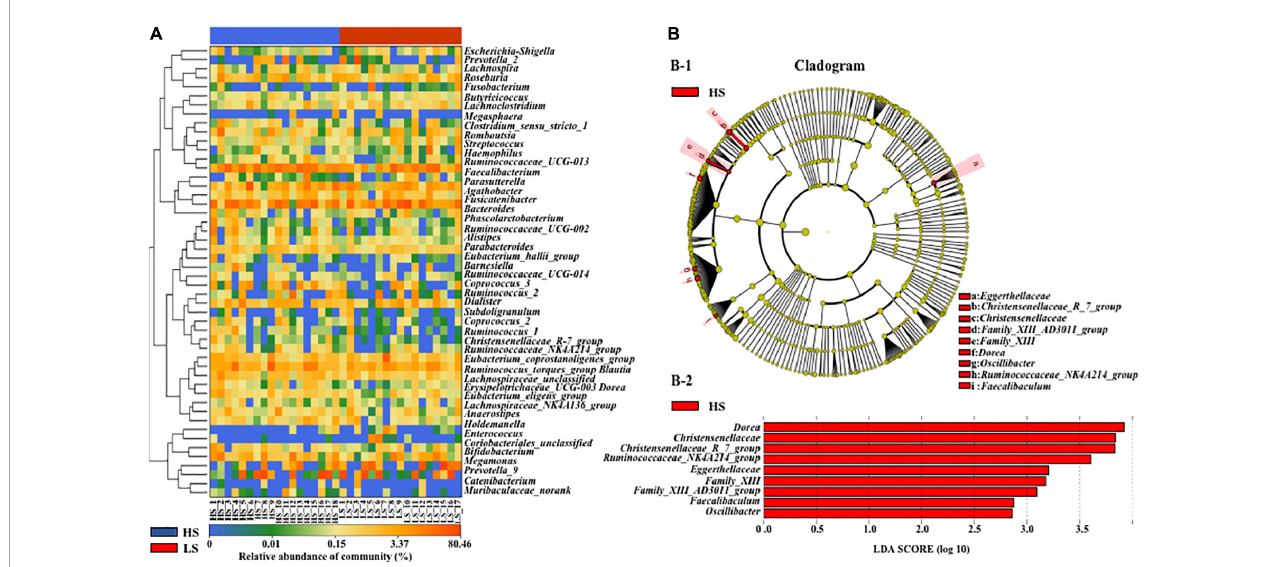
FIGURE4 Heat map of 50 top genera in HS and LS groups (A) and difference of meaningful bacterial taxa (B) in HS and LS groups. (B-1) Taxonomic represents a statistical difference in groups. (B-2) Histogram of the LDA scores for differential abundant genera. HS, the high-status NCPB; LS, the low-status NCPB.